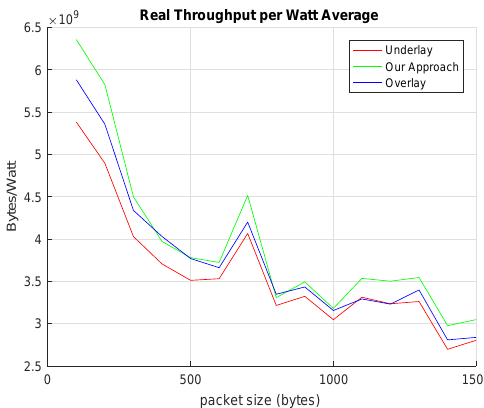
Figure 6. Average total performance depending on the type of traffic in the C-UE.